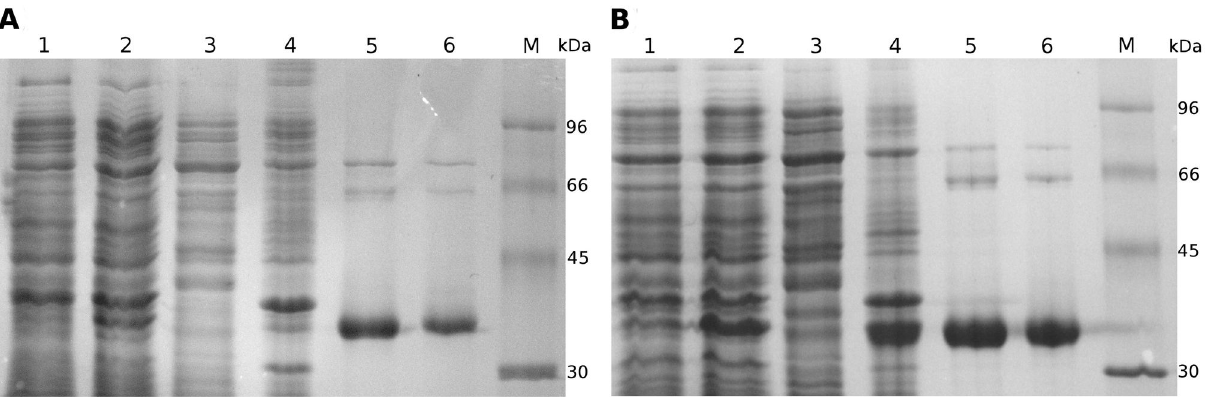
Figure 6. Purification of DzmP (A) and Ssrg_00986 (B) after expression as His before IPTG induction; lane 2 , total protein after IPTG induction; lane 3 , soluble protein after IPTG induction; lane 4 , insoluble protein after IPTG induction; lane 5 , protein after Ni 2+ affinity chromatography; lane 6 , protein after buffer exchange over Sephadex G-25; lane M , molecular mass standards. The calculated masses are 34.8 kDa for both enzymes. The 12% polyacrylamide gel was stained with Coomassie Brilliant Blue